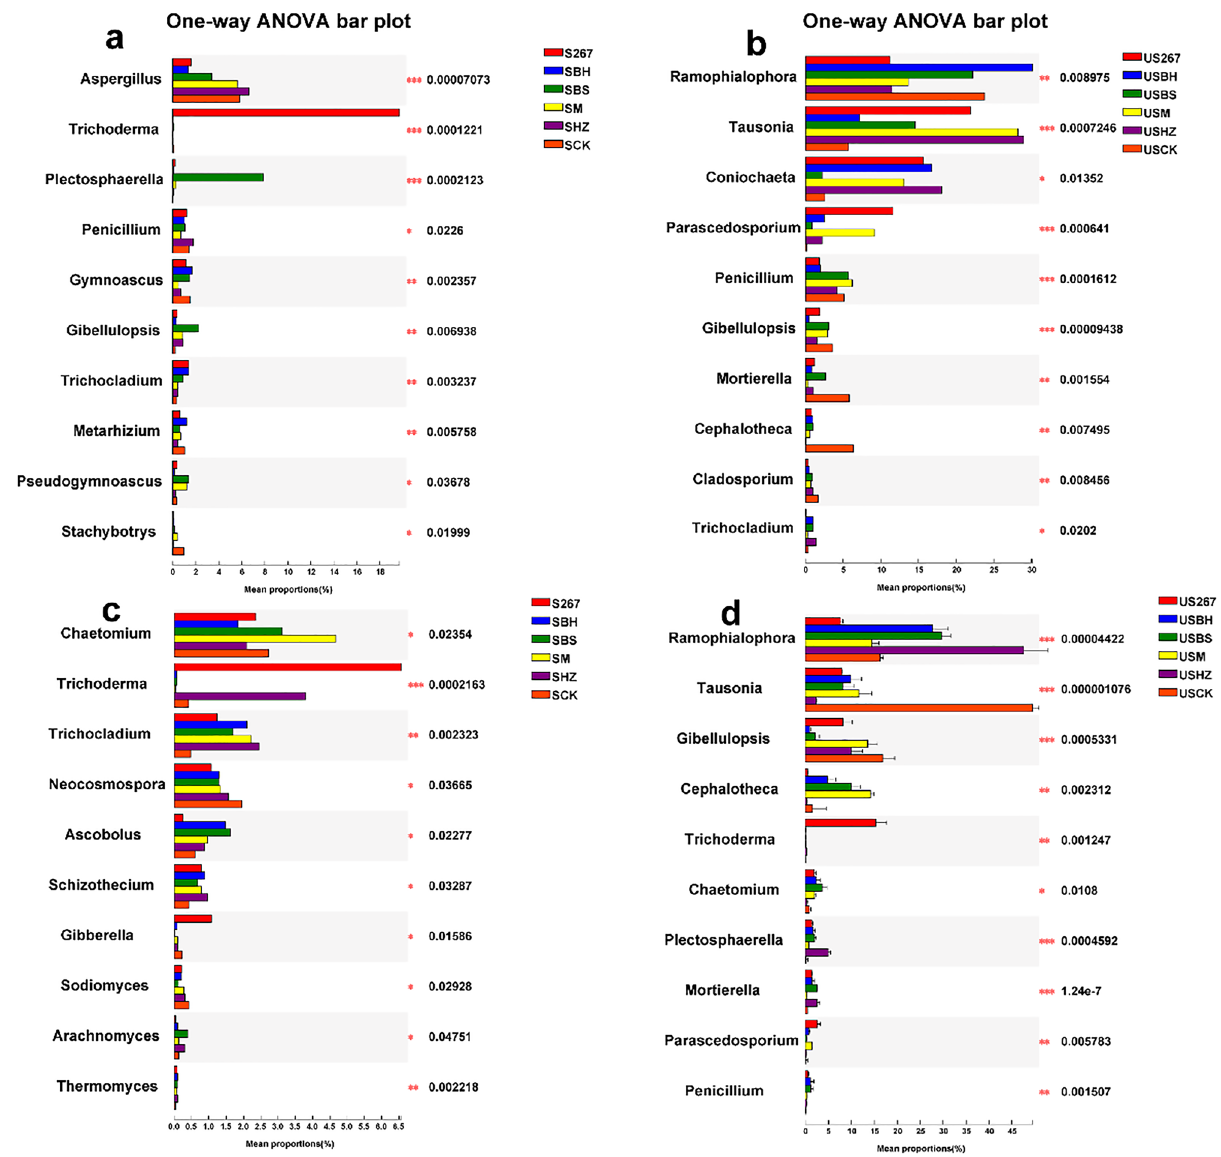
Figure 5. Relative abundance of fungal genera detected in soil and substrate after different biofertilizer treatments in soil ( a early samples; c late samples) and substrate ( b early samples; d late samples). The number of asterisks indicates significant differences between treatments according to a one-way ANOVA and FDR (False Discovery Rate) adjustment (*0.01 < P ≤ 0.05; **0.001 < P ≤ 0.01; ***P ≤ 0.001). S267 = Trichoderma Strain 2 67 added to soil; SBH = Bacillus subtilis and T. harzianum biofertilizers added to soil; SBS = B. subtilis biofertilizer added to the soil; SM = Compound biofertilizer added to soil; SHZ = T. harzianum biofertilizer added to soil; SCK = Untreated soil. US267 = T. 267 biofertilizer added to substrate; USBH = B. subtilis and T. harzianum biofertilizers added to substrate; USBS = B. subtilis biofertilizer added to substrate; USM = Compound biofertilizer added to substrate; USHZ = T. harzianum biofertilizer added to substrate; USCK = Untreated